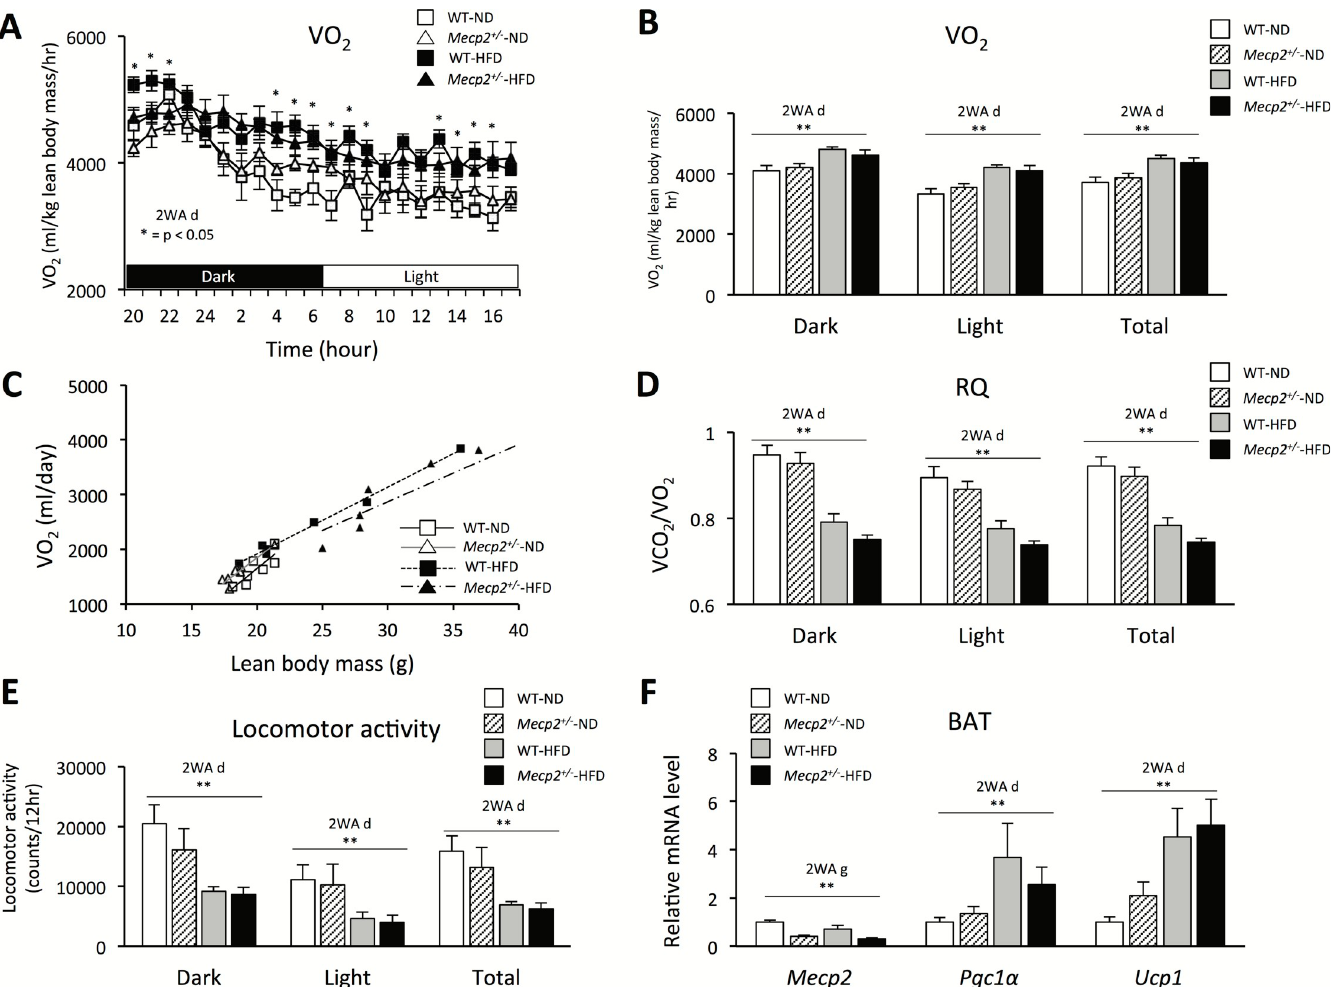
Fig 3. Oxygen consumption, locomotor activity, and brown adipose tissue-related gene expression in Mecp2 +/- mice. (A) Twenty-two-hour oxygen consumption adjusted by lean body mass. (B) Oxygen consumption in dark and light phase. (C) Oxygen consumption analyzed by ANCOVA. (D) Respiratory quotient (VCO 2 /VO 2 ). (E) Locomotor activity. (F) Mecp 2, Ucp1 and Pgc1 α mRNA expression in the BAT using qPCR. (A–F) Mice were tested at 16 weeks of age; values are the mean ± SEM for 7–8 mice. � = p < 0.05, a p < 0.05, �� = p < 0.01, 2WA = Two-way ANOVA, g = genotype, d = diet, Two-way ANOVA followed by post-hoc Tukey-Kramer Multiple- Comparison